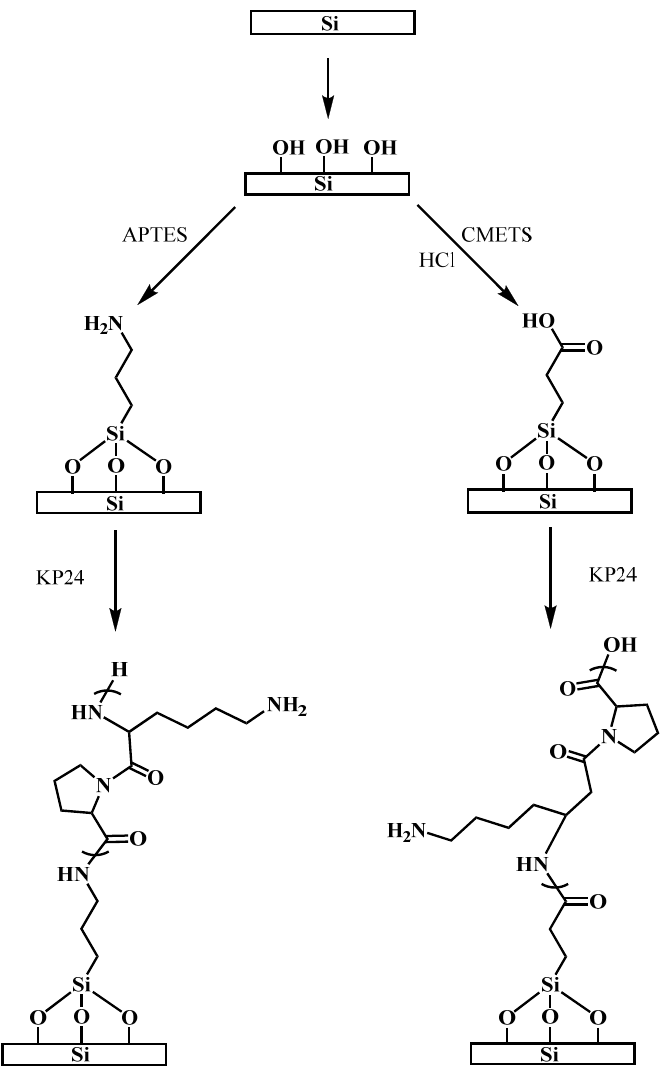
Figure 1. Scheme of immobilization of KP24 on glass surface by silane coupling agent.